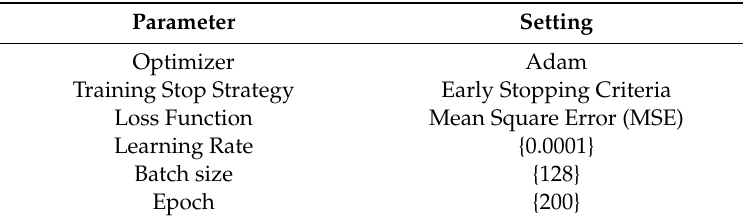
Table 2. Parameter settings of proposed MH-CNN model.